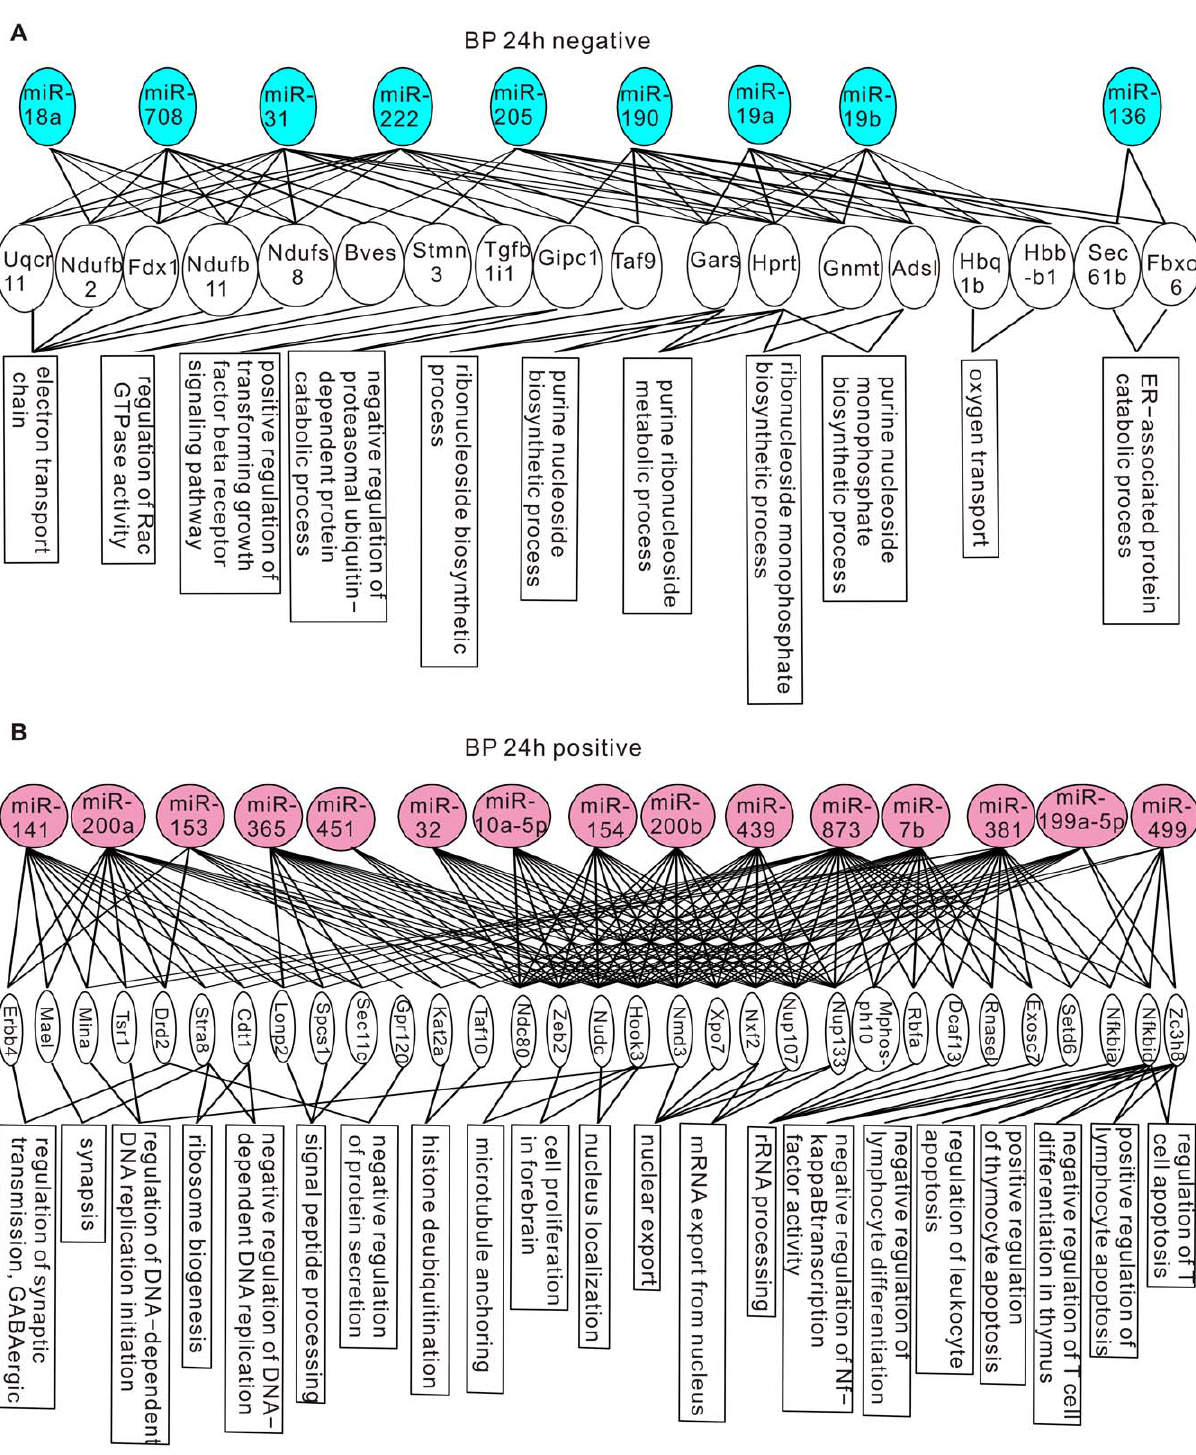
biological functions regulated by differentially expressed miRNAs.